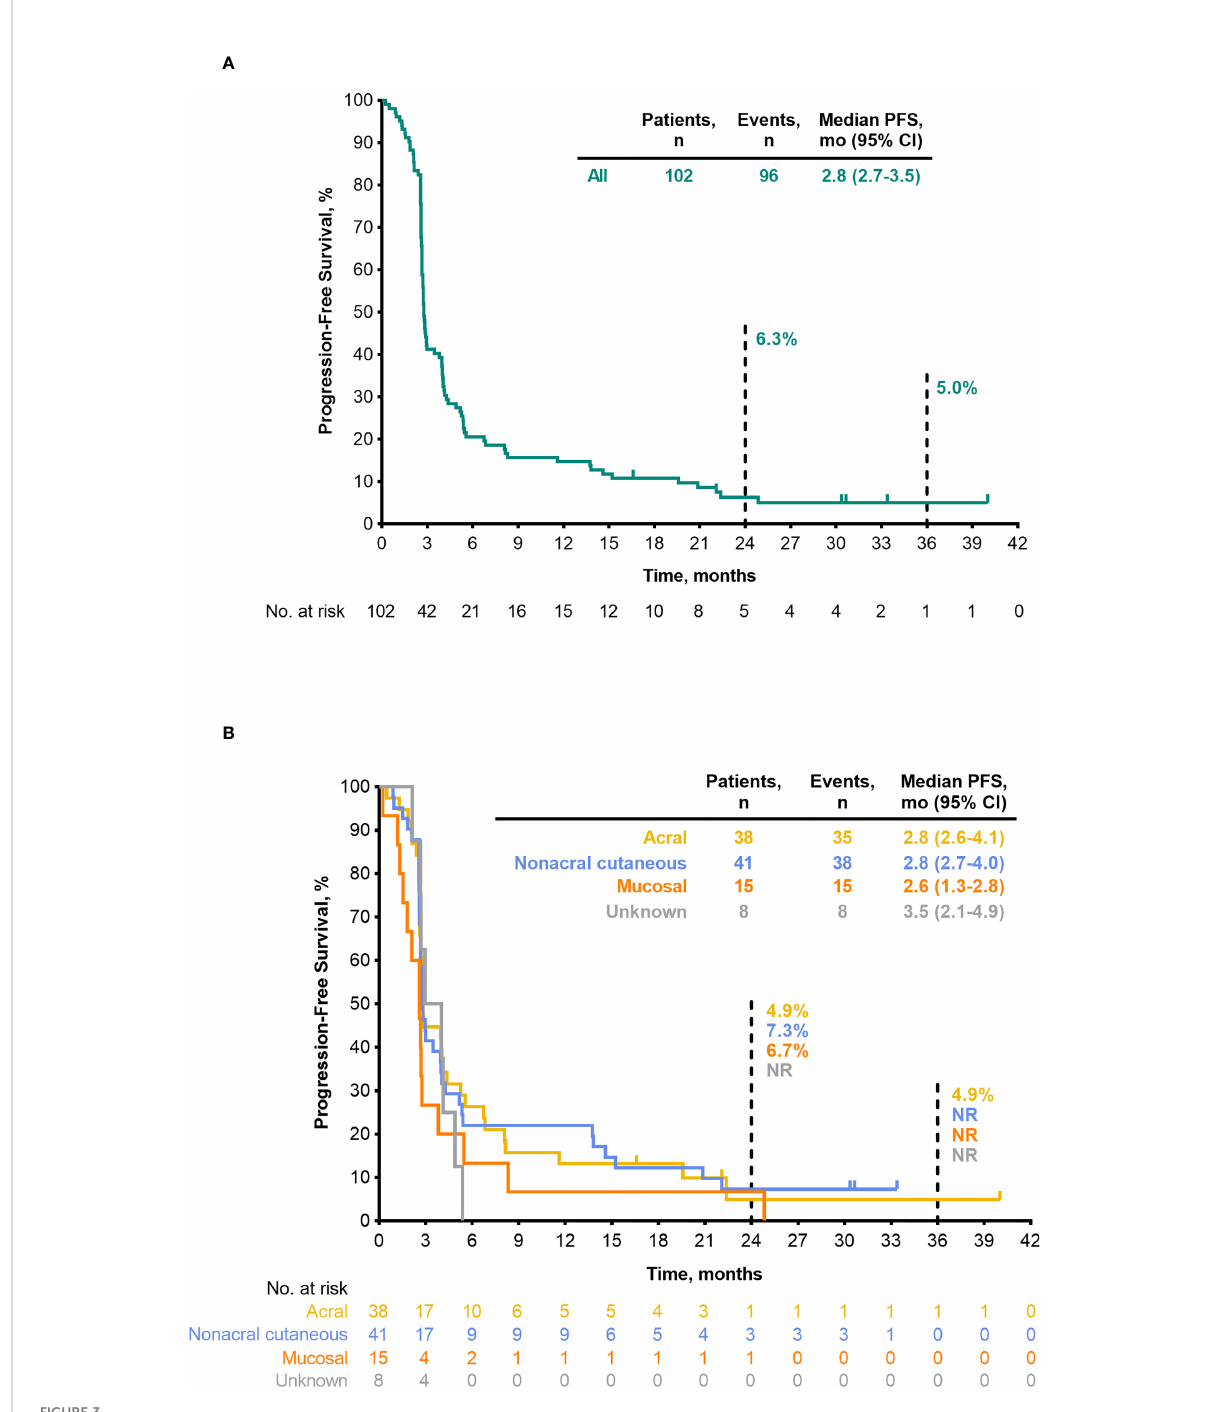
FIGURE 3 PFS per RECIST v1.1 by BICR (FAS population) (A) all patients (B) by melanoma subtype. BICR, blinded independent central review; FAS, full analysis set; NR, not reached; PFS, progression-free survival; RECIST v1.1, Response Evaluation Criteria in Solid Tumours, version